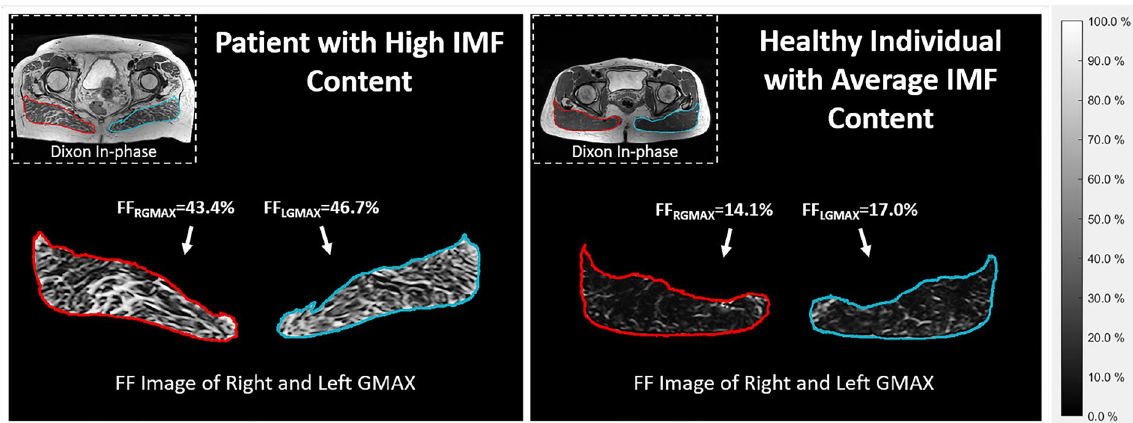
Figure 3. Example cases for different levels of FF. Axial slice of the FF image of right and gluteus maximus for a subject with high fat infiltration from the patient group and for a healthy subject of the medium activity group with a GMAX FF close to the average for this group. The FF values of each muscle are included in the images. On the top left corner of each image, the in-phase Dixon MR image of each case is are visible. For the patients group, the FF values were not different between left and right. In addition, we did not find any significant difference when comparing the side with the affected hip and the asymptomatic side (median − 0.5%, Wilcoxon signed-rank test, p = 0.90).